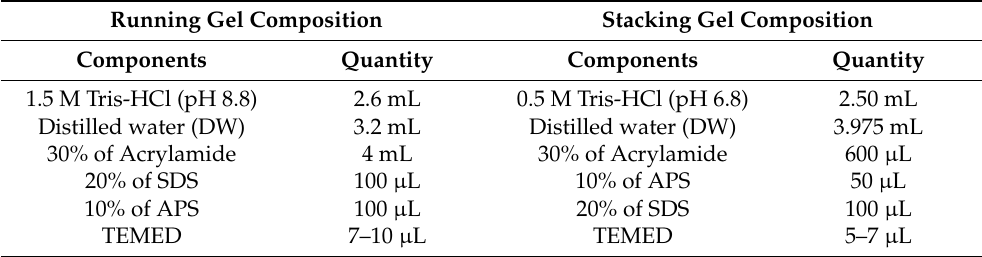
Table 1. Chemical composition of gel for running and